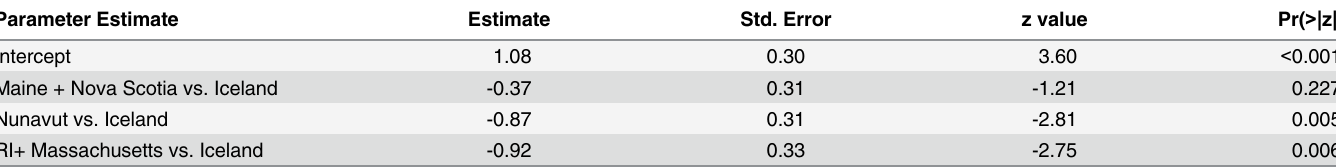
Table 3. Parameter estimates from the best model of common eider seroprevalence as selected by Akaike Information Criteria (n = 1550). Parameter